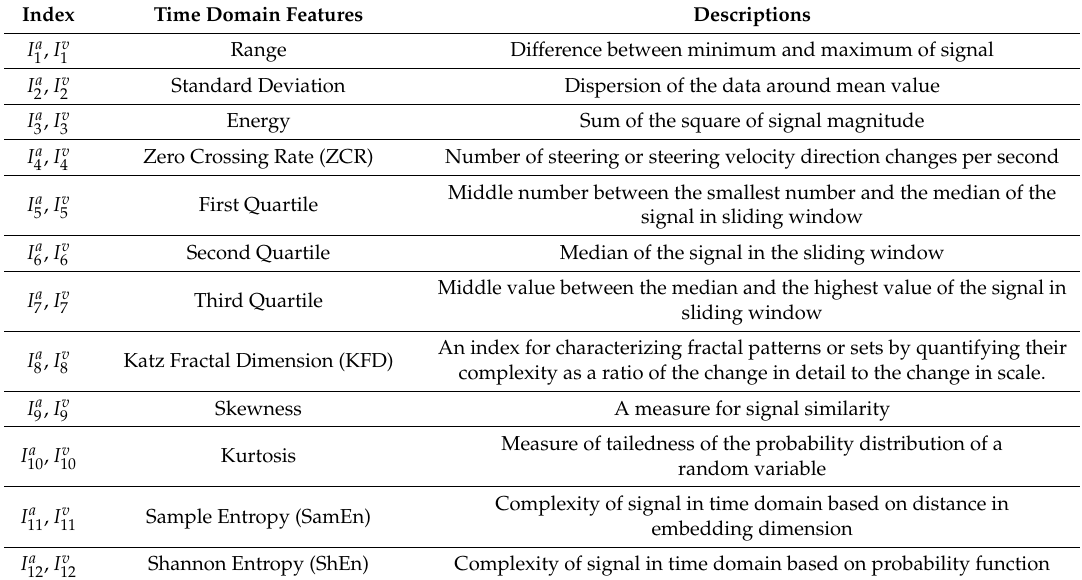
Table 1. Extracted time domain features from steering angle and velocity signals.